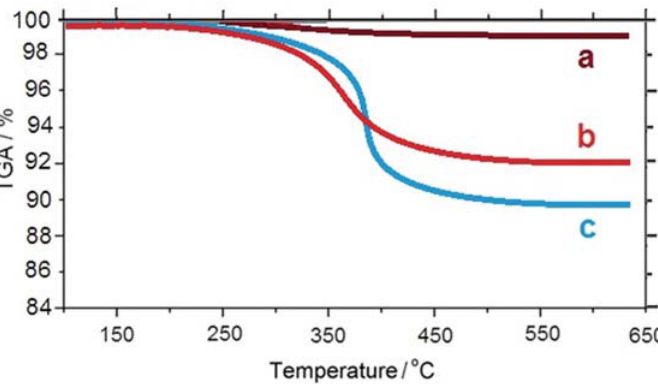
Fig. 5: TGA thermo-gram of: (a) un-modified alumina NPs; (b) alumina NPs modified by TMVS; (c) alumina NPs modified by oleic